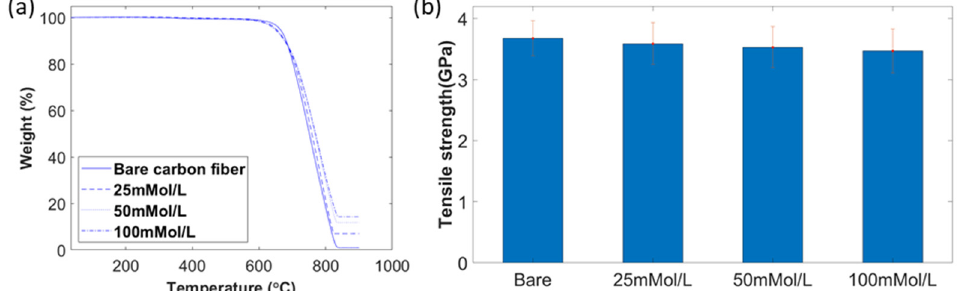
Figure 4. ( a ) TGA of bare carbon fiber and carbon fiber with ZnO nanowires; ( b ) tensile strength of bare carbon fiber and carbon fiber with ZnO nanowires.